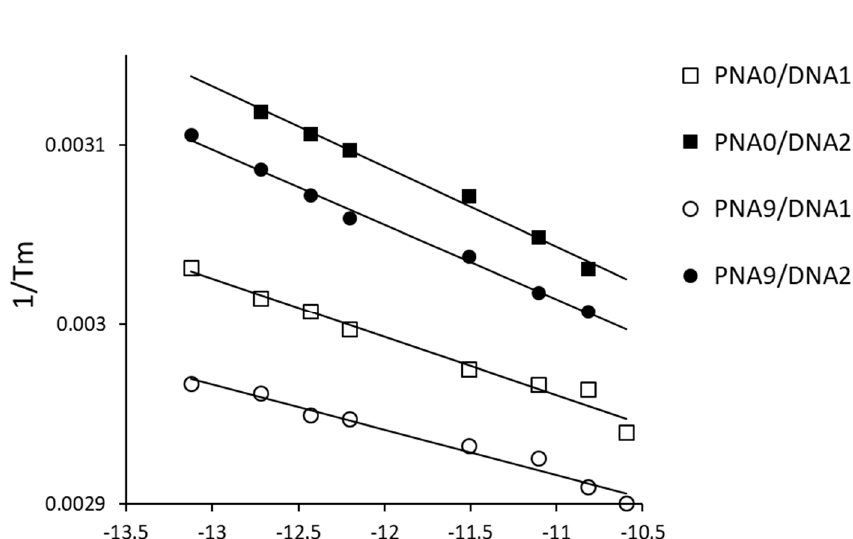
Figure 7. Tm plot of the PNA/DNA and tolane-PNA/DNA duplexes at different concentrations in 20 mM phosphate buffer (pH 7.4). The R/ ∆ H values were calculated from the slope of each approximate straight line. The ∆ S/ ∆ H values were calculated from the estimated intercept on the 1/Tm line as ln(Ct/4) approached zero.